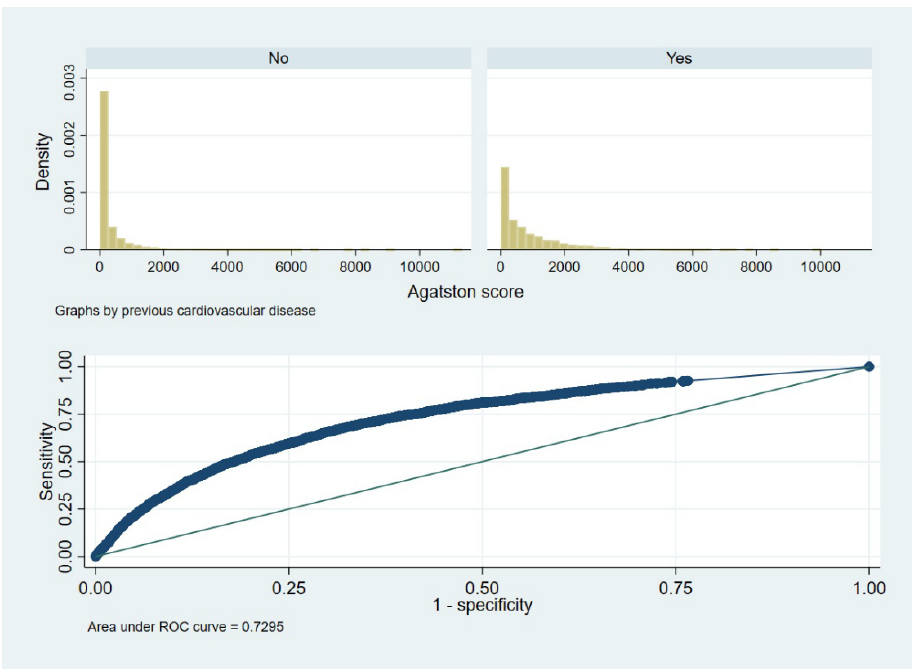
based on 10,000,000 observations with a prevalence of 0.5.